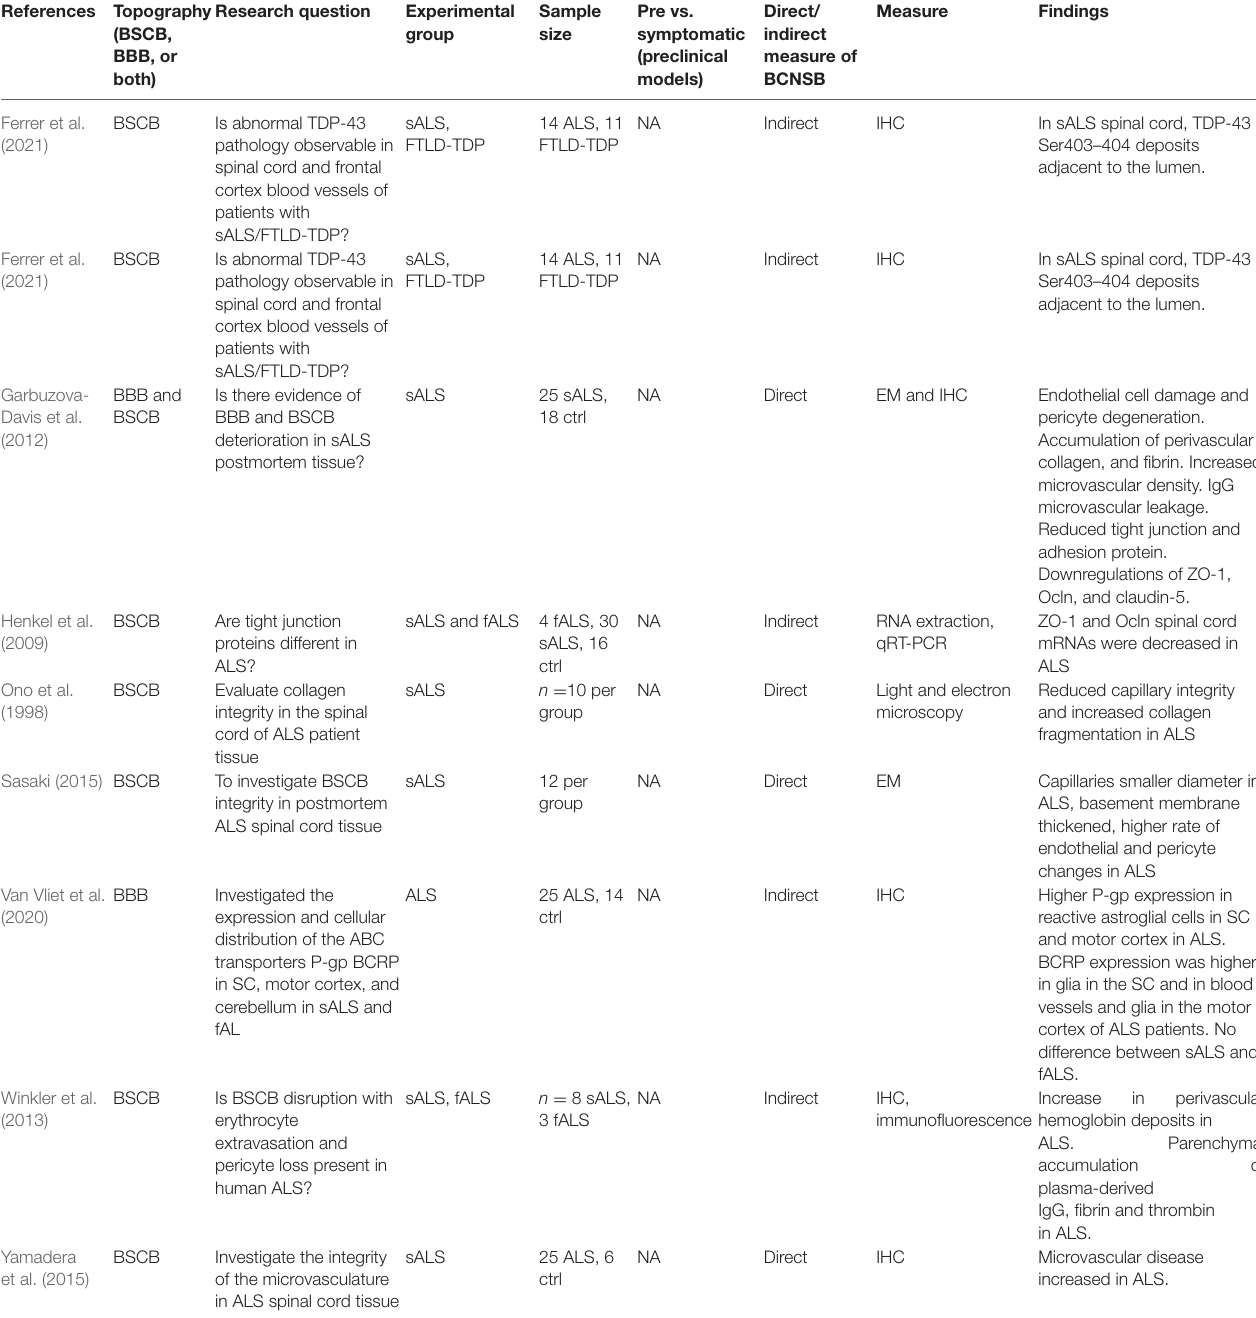
TABLE 2 | Human post-mortem studies investigating BCNSB integrity and function in ALS. References Topography